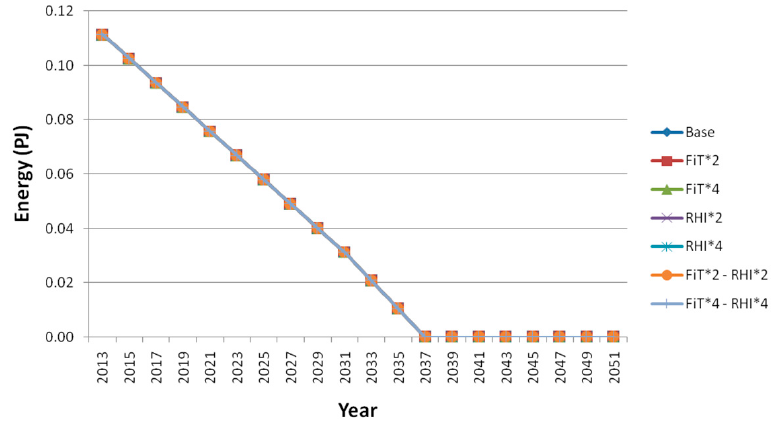
Figure 15. Specialist pig farms—fuel consumption.